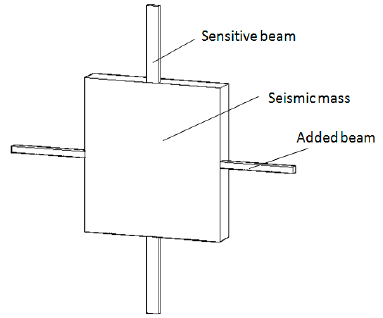
Figure 1. Diagram of the design structure.